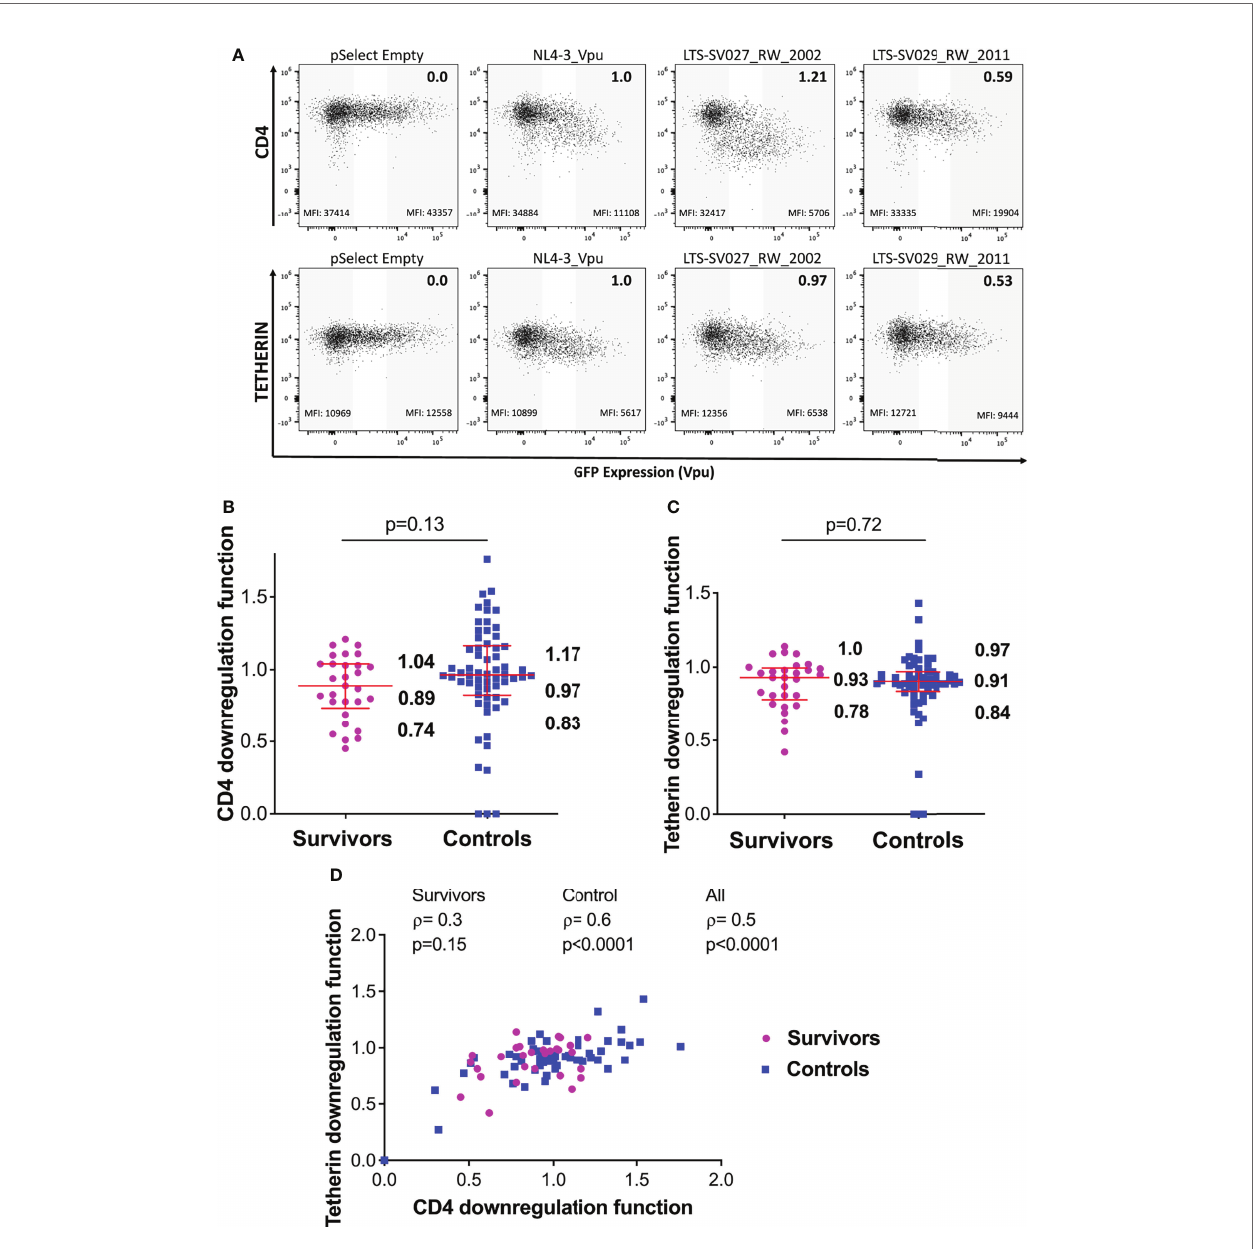
FIGURE 4 | Vpu-mediated CD4 and Tetherin downregulation function in survivors and controls. (A) Representative fl ow cytometry plots showing downregulation of CD4 (top) or tetherin (bottom) following transfection of negative control (pSelect empty vector), positive control (NL4.3 Vpu), a representative functional clone and a representative poorly-functional clone. Gray shading at the left of each plot denotes the GFP-negative (untransfected) gate used for quanti fi cation, whereas grey shading at the right denotes the corresponding GFP-high (Vpu-expressing) gate. Median fl uorescence intensity (MFI) of receptor expression is indicated at the bottom of each gate, and the NL4.3-normalized downregulation function (calculated as described in the Methods) is indicated in the top right of each plot. (B) Vpu mediated CD4 downregulation functions of LTS and controls. Red box and whiskers denote the median and interquartile range, with values indicated on the plot. P-value is calculated using the Mann-Whitney U-test. (C) Comparison of Vpu mediated Tetherin downregulation function among LTS and controls. (D) Relationship between Vpu-mediated CD4 and Tetherin downregulation functions in individual and combined cohorts, assessed using Spearman ’ s